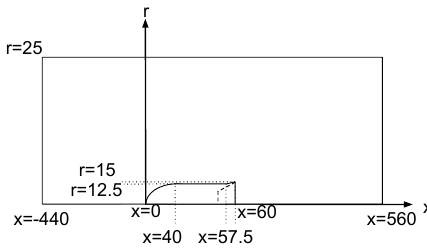
Figure 1. Schematic (not to scale) of the configuration of the U-Melbourne combustor.